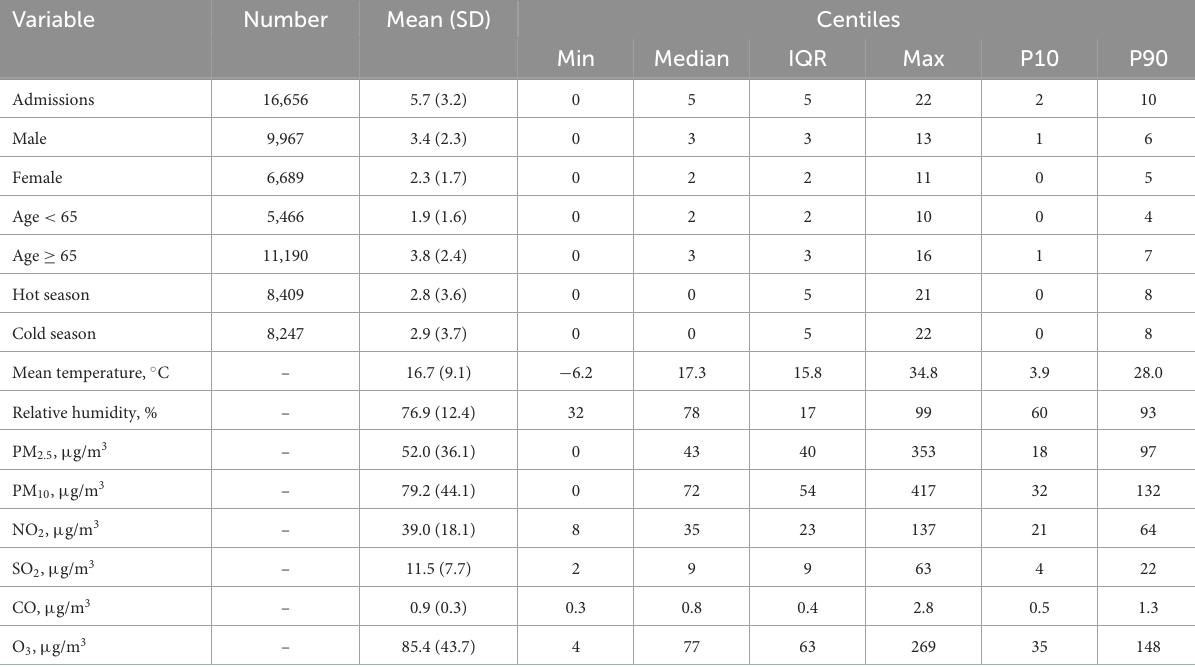
TABLE 1 Summary statistics of air pollutants, meteorological factors, and outpatients for CHD in Hefei, 2014–2021. Variable